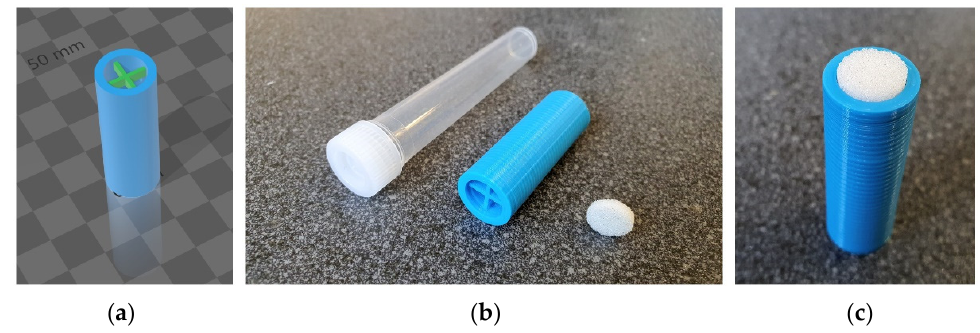
Figure 2. SLIDE—sweat sampling device consisting of a 3D-printed attachment, porous glass filter disk, and a plastic tube with a cap. 3D model of adapter ( a ), deconstructed parts ( b ), finally composed ( c ).